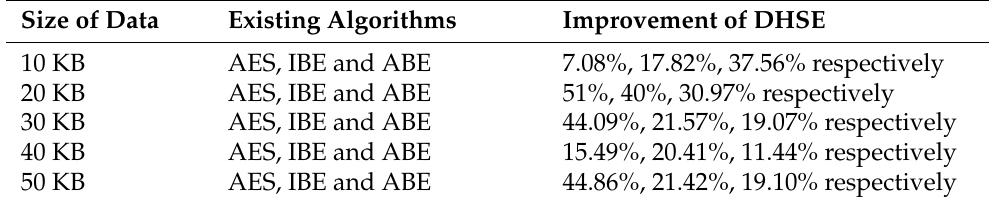
Table 2. Improvement of DHSE in encryption over AES, IBE and